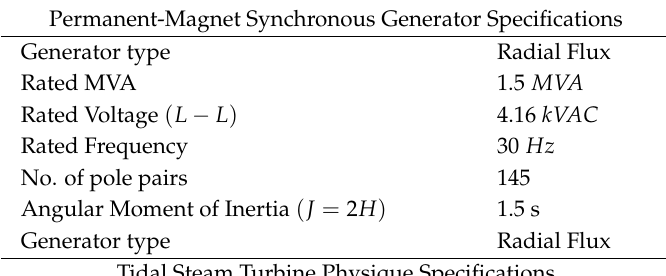
Table A1. Specifications and ratings of proposed